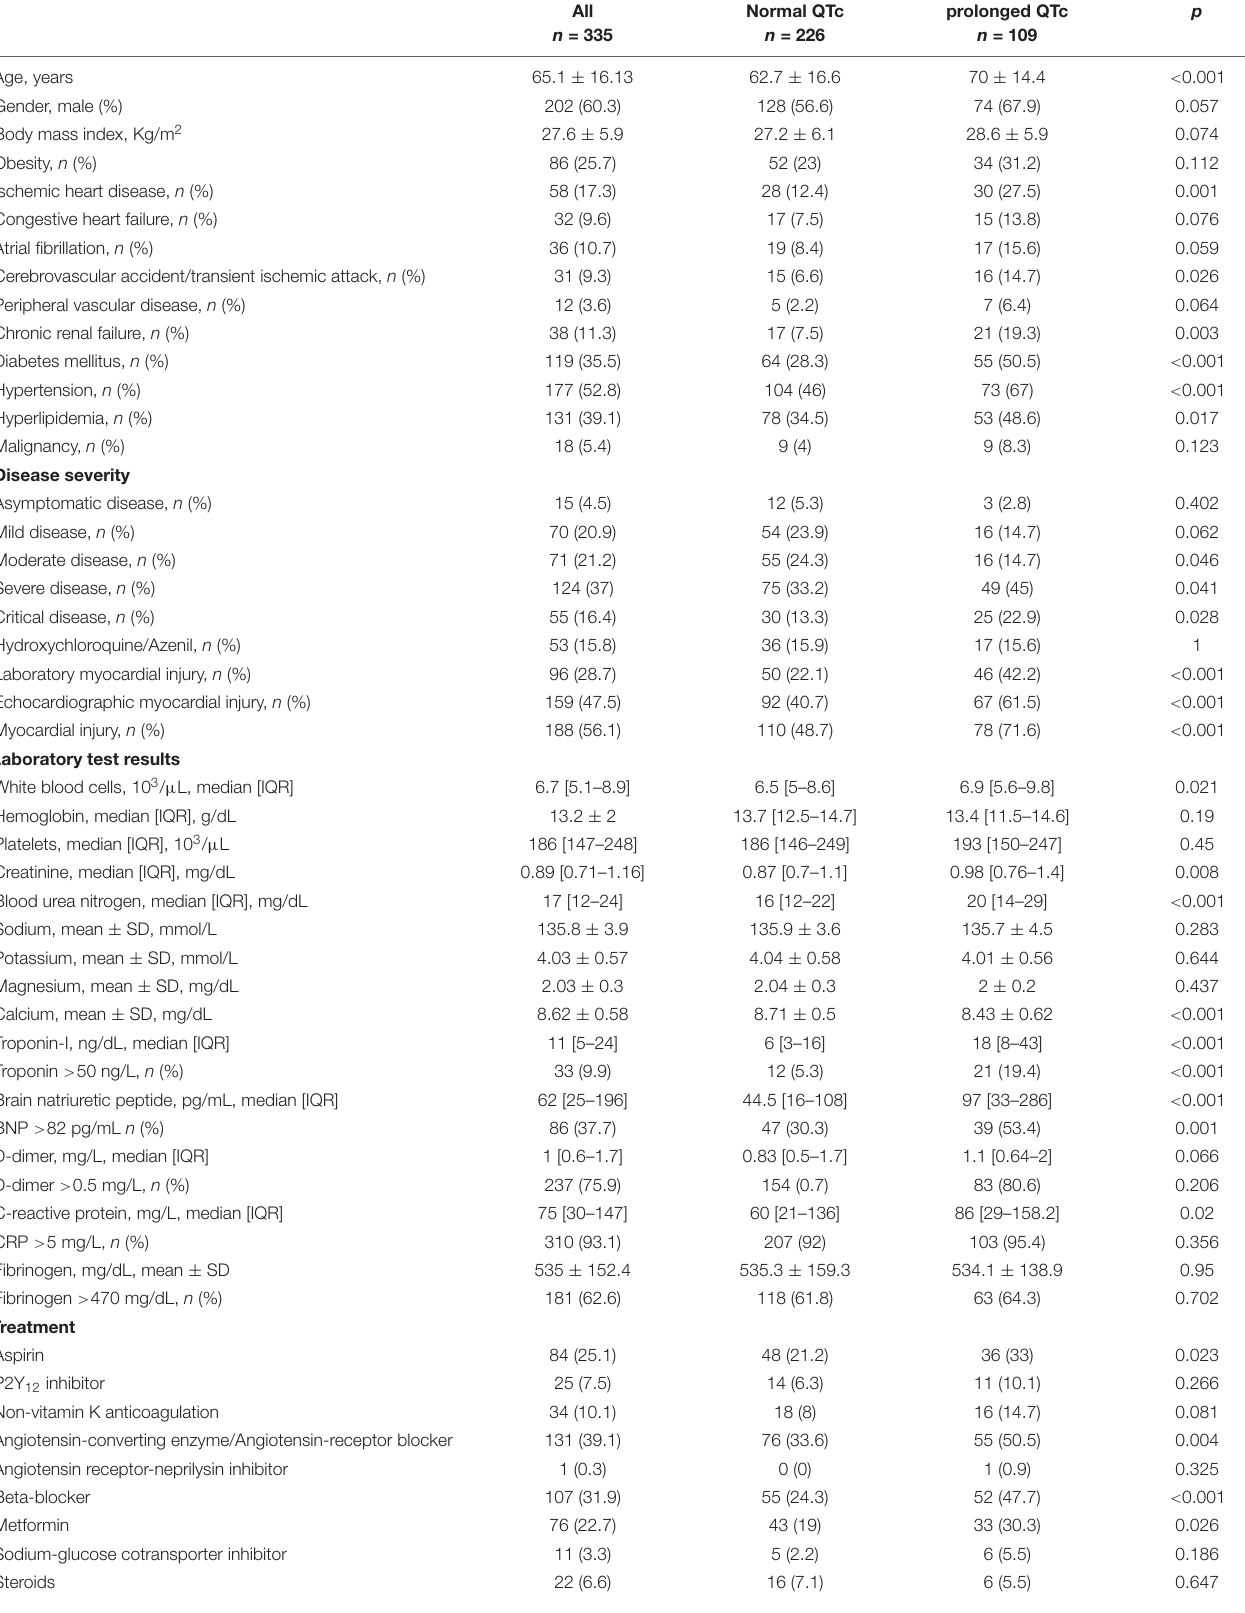
TABLE 1 | Baseline